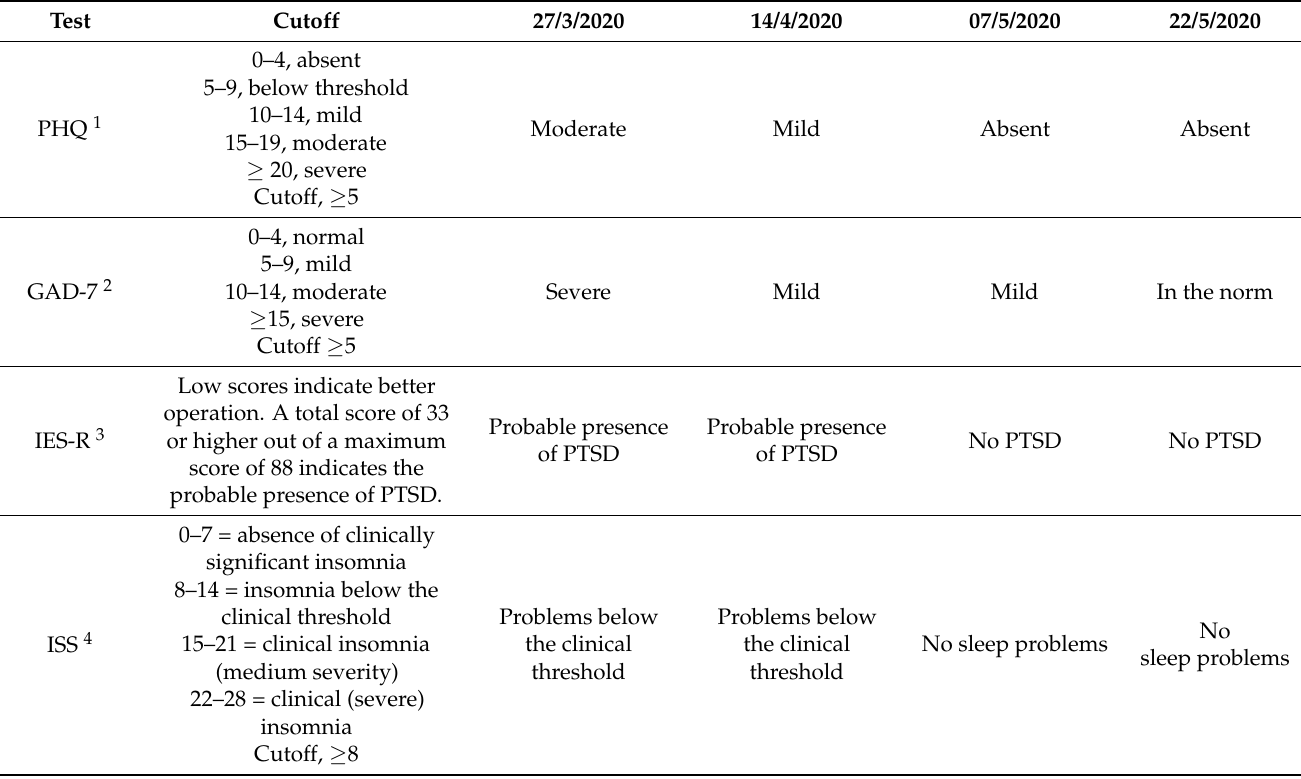
Table 1. Cutoffs and results of the longitudinal psychometric